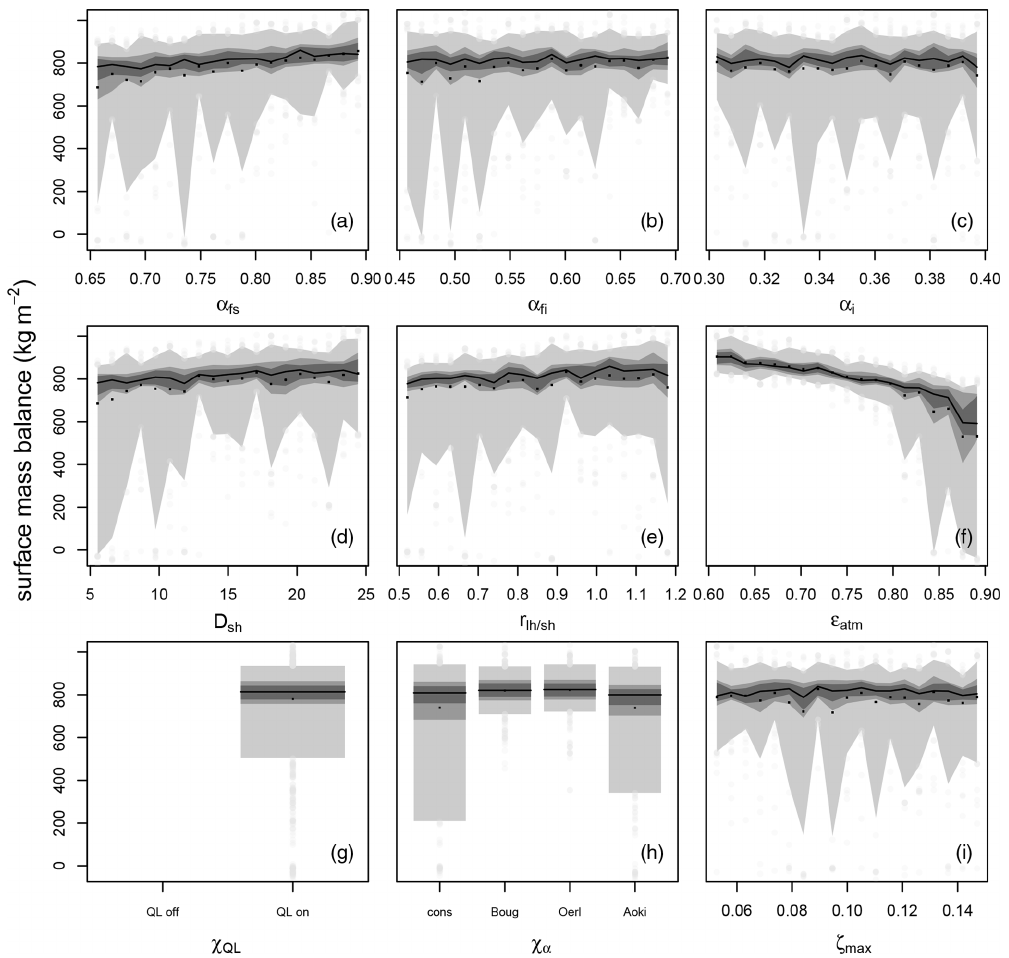
Figure A2. The ensemble statistics for the surface mass balance for the entire ensemble at region 5 (west 1000–2000m) in the LGM, showing the 5th and 95th, 25th and 75th, 33rd and 66th, and 50th quantiles in progressively darker shading. Black points represent the ensemble mean, and the grey points correspond to the rest of the ensemble, apart from outliers (max five per bin allowed), which are removed to improve readability. Each plot represents the range of one parameter with α fs , α fi , and α i in the top row; D SH , r lh / sh , and (cid:15) atm in the middle; and Q Lon / off , χ α , and ζ max at the bottom. As Q Lon / off and χ α have two and four discrete values, respectively, the parameter range is not split into 20